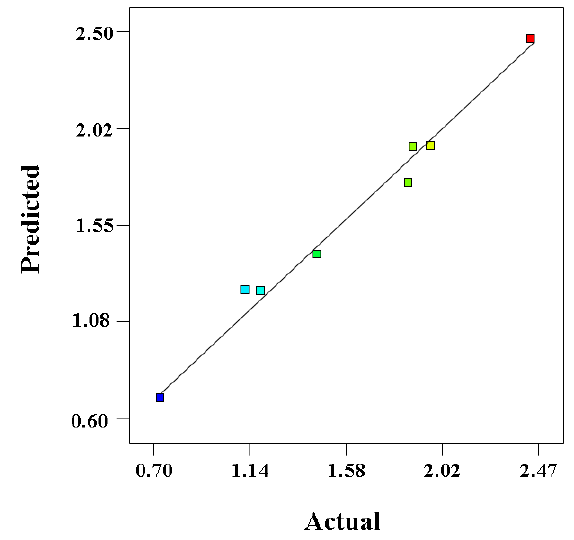
Figure 3. Diagnostic plots (predicted vs. actual) of model adequacy for the extraction. Table 2. Analysis of variance (ANOVA) for the model fitted to the SC-CO 2 extraction process of rosemary essential oil.